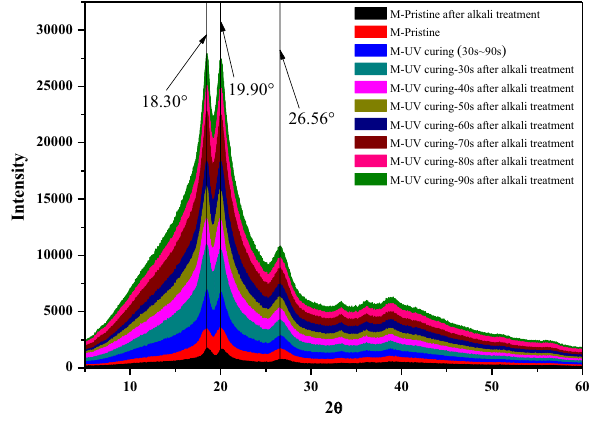
Fig. 5 The effect of alkali treatment on the crystal form of pristine PVDF membrane and UV-curable resin-modified PVDF membrane (the XRD spectrum of the UV-curable resin-modified PVDF mem- brane (30–90 s) is basically same)